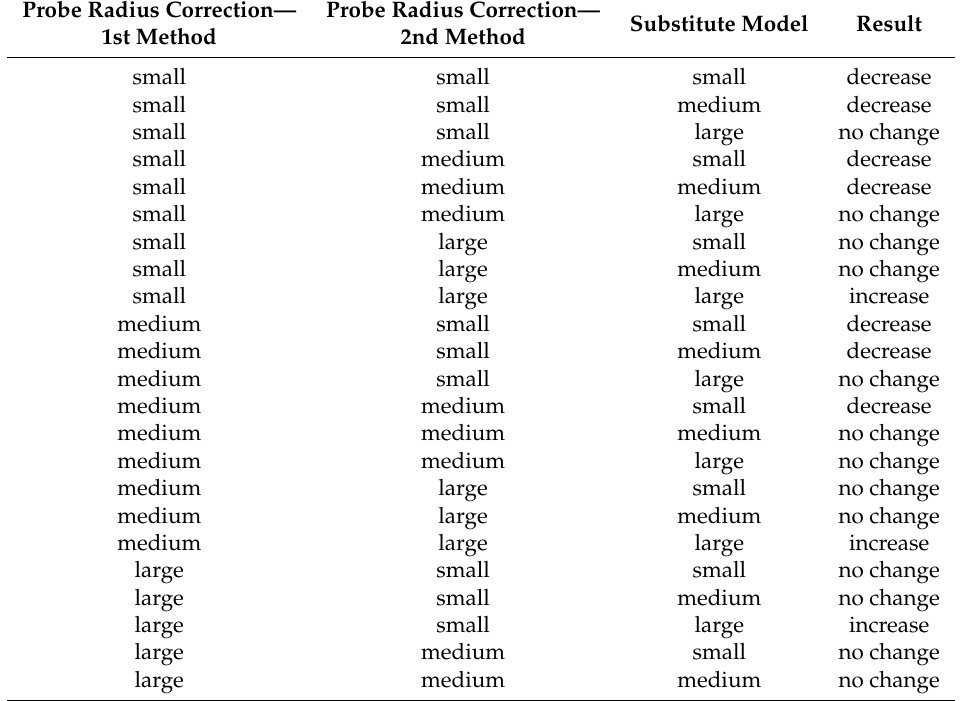
Table 2. The selected rules for the second part of the developed